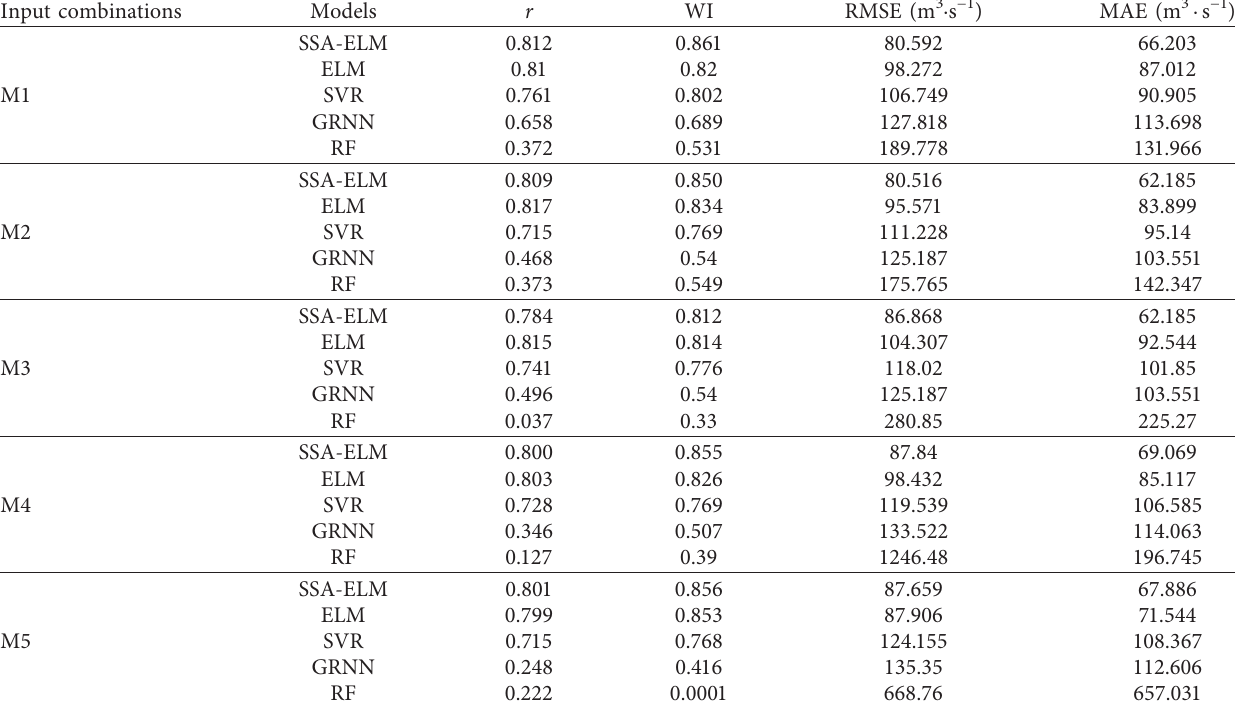
Table 2: Performance evaluation for ELM and SSA-ELM, SVR, GRNN, and RF models. Input combinations